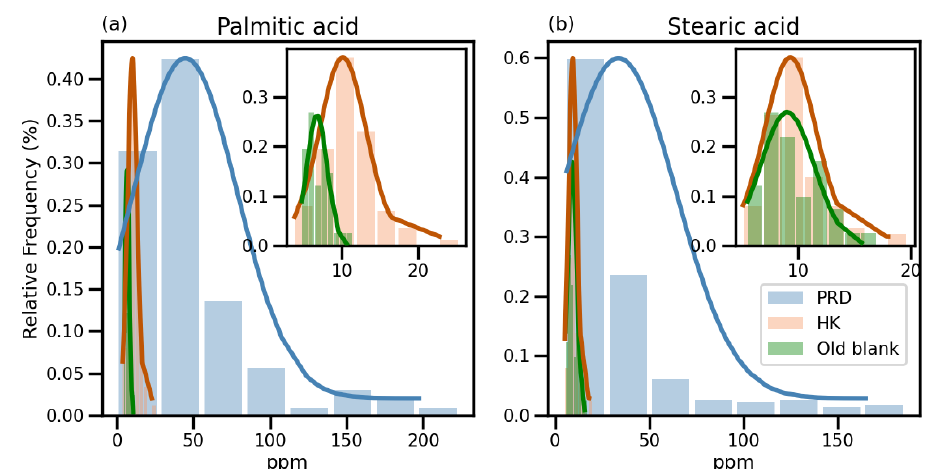
Figure 3. Contrast of concentrations of ( a ) palmitic acid and ( b ) stearic acid as measured by the original method and shown as relative frequency distribution histograms for field blanks ( n = 39, marked in green color), ambient samples from Hong Kong ( n = 87, marked in cantaloupe brown color) and the Pearl River Delta region ( n = 175, marked in sky blue color). Insert plots are zoomed-in images of the histograms of field blanks and the Hong Kong (HK) samples. The solid lines denote the normal distributions of the corresponding data.